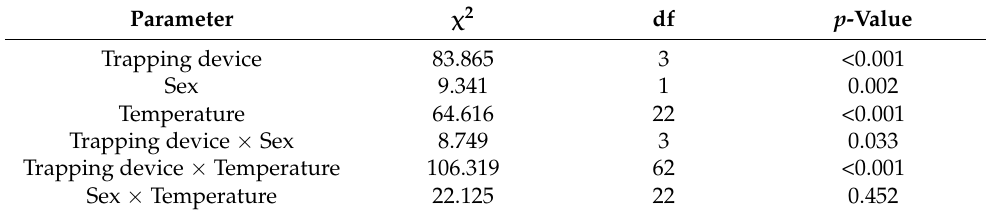
Table 1. Results of the GLMs on the performance of the trapping device, sex, temperature and two-way interactions on the captures in the semi-field cage trials.